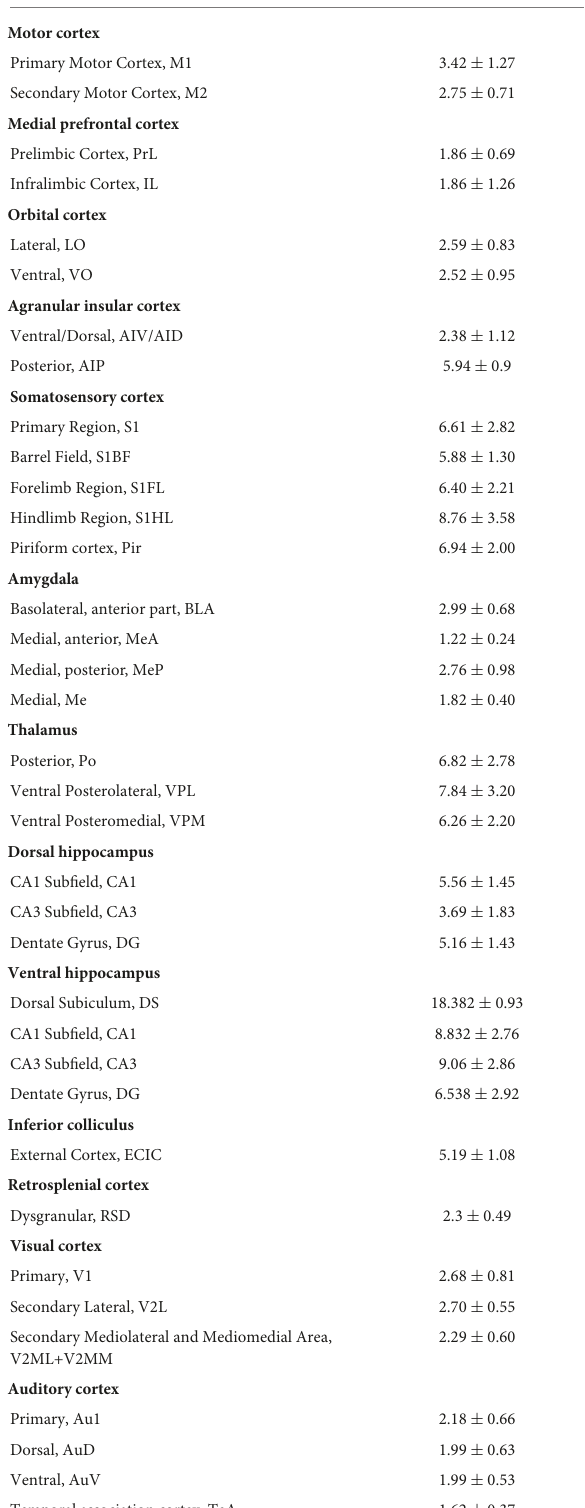
TABLE 1 Quantitative assessment of the average A β plaque deposition in the brain of 5xFAD mice. Brain regions Plaque burden (%) ±